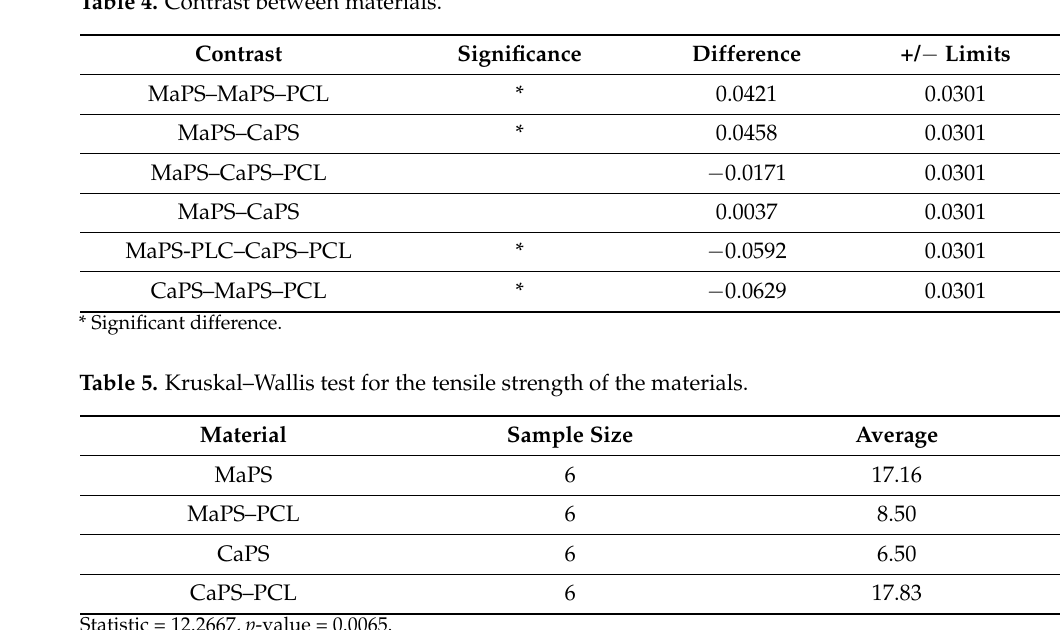
Table 4. Contrast between materials.